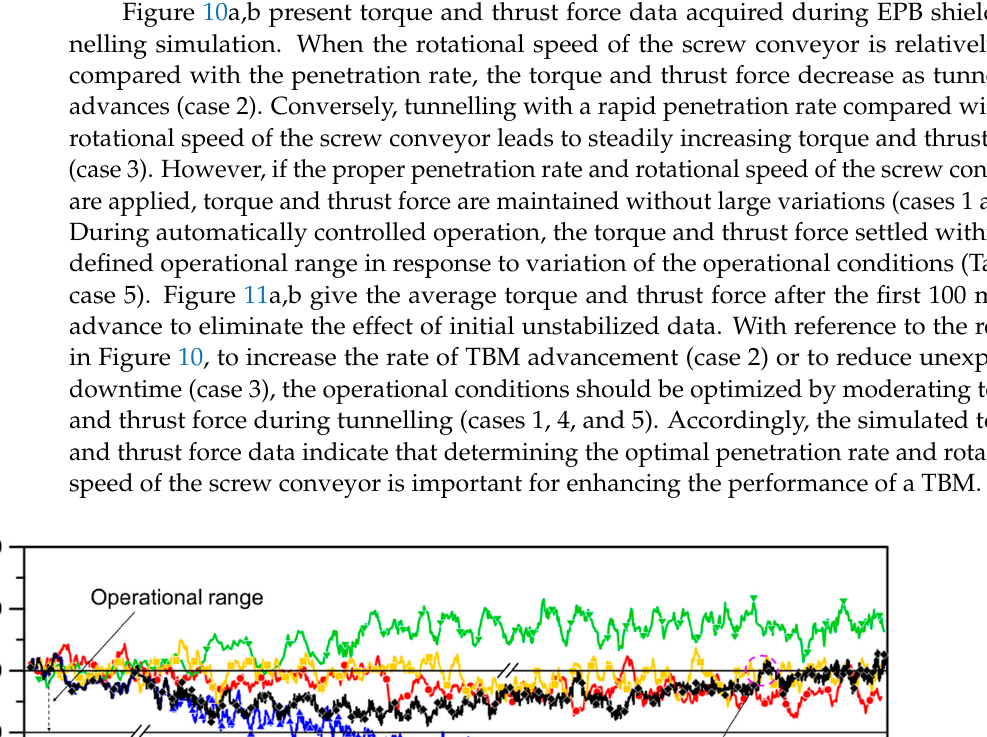
Figure 10. Measured torque and thrust force data during EPB shield tunnelling simulation: ( a ) torque; ( b ) thrust force.